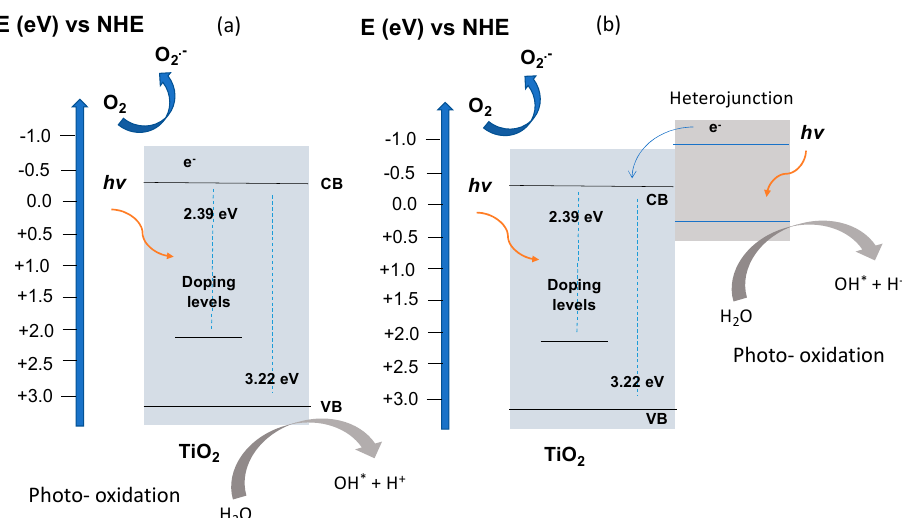
Scheme 1. Hypothetical scheme of energetic levels for metal-doped ZnO thin films: ( a ) Metal doping process. ( b ) Metal doping process and the generation of a heterojunction [64,70,71]. After charge pairs generation, the ROS can be yielded on the catalyst surface and MB degradation